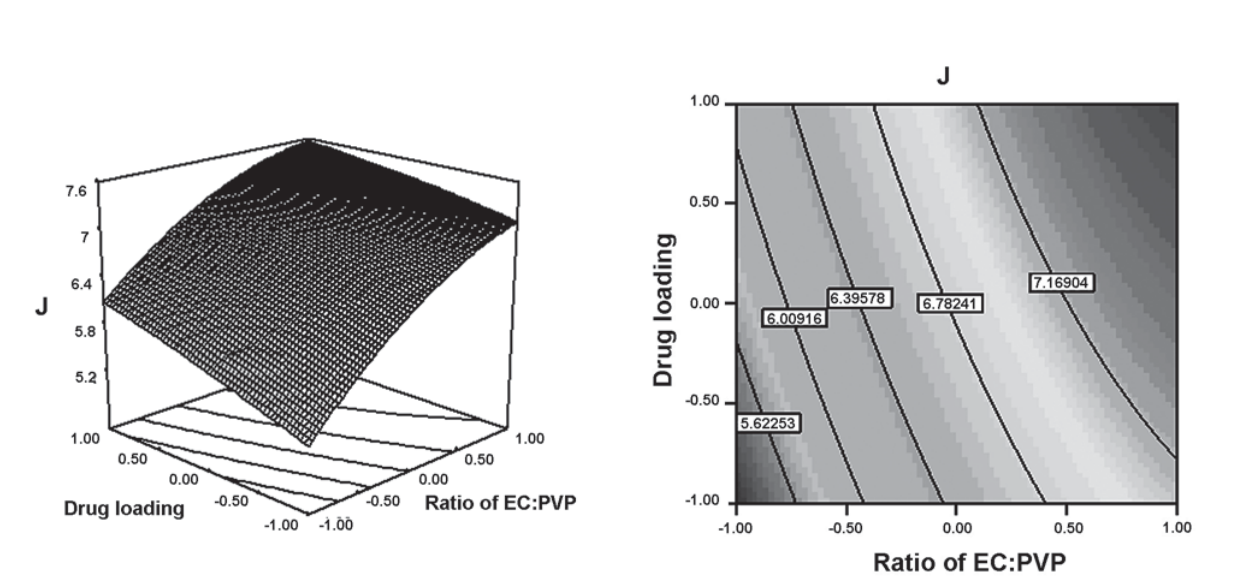
Figure 7 – Response surface plot for permeation flux (J) indicat- ing the effect of the ratio of EC: PVP and drug loading on